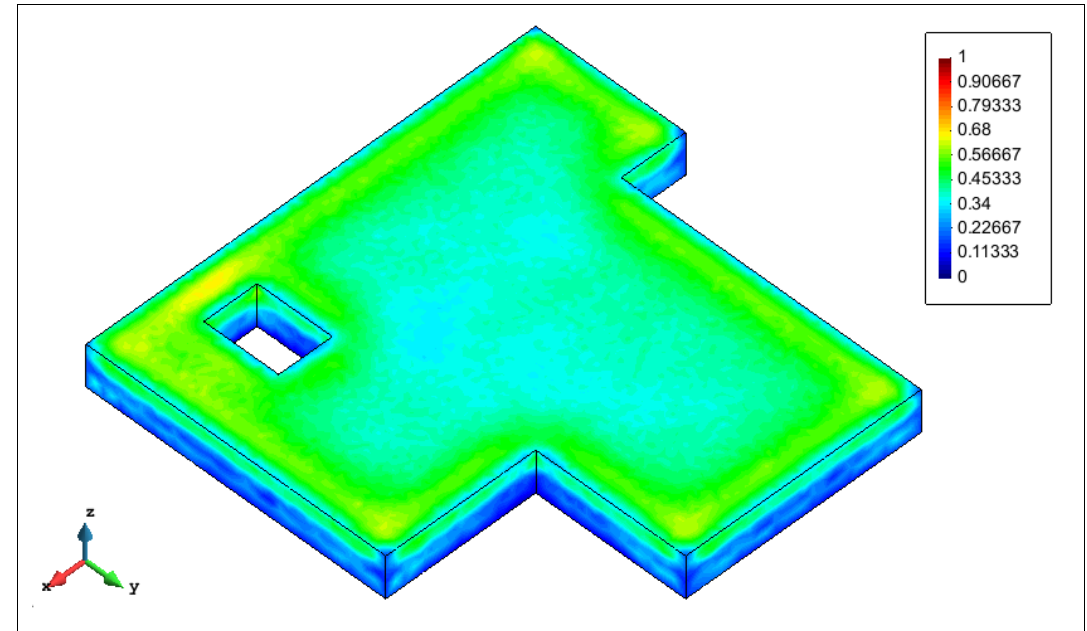
Figure 10. Cracking index field for the optimal solution.